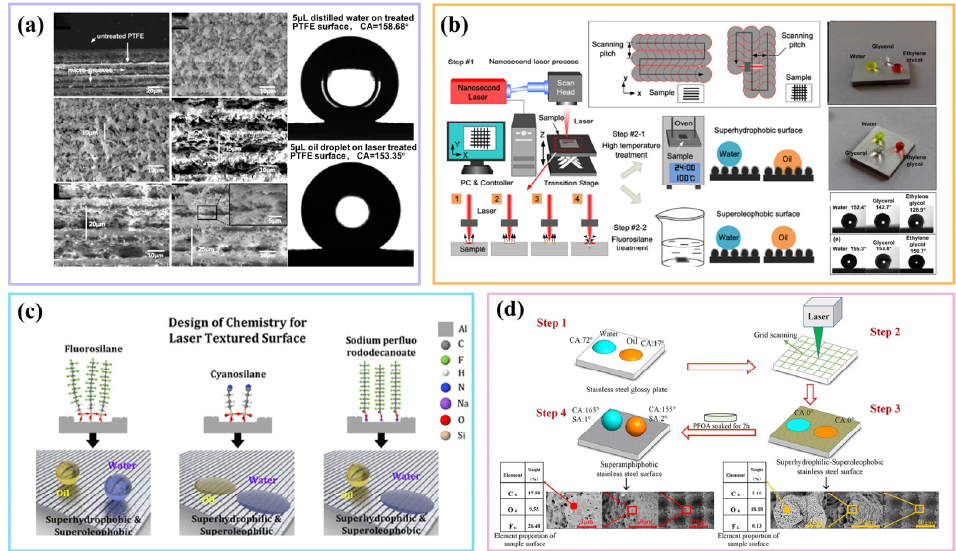
Figure 10. Laser preparation of superamphiphobic surface surfaces: ( a ) PTFE microgrooves machined by femtosecond laser [109], ( b ) Aluminum alloy superamphiphobic surface prepared by laser etching [91], ( c ) Superamphiphobic aluminum alloy surface in FOTS, FDTS and FDDTS solutions [110], ( d ) Laser etching of reticulated stainless-steel surface [111].